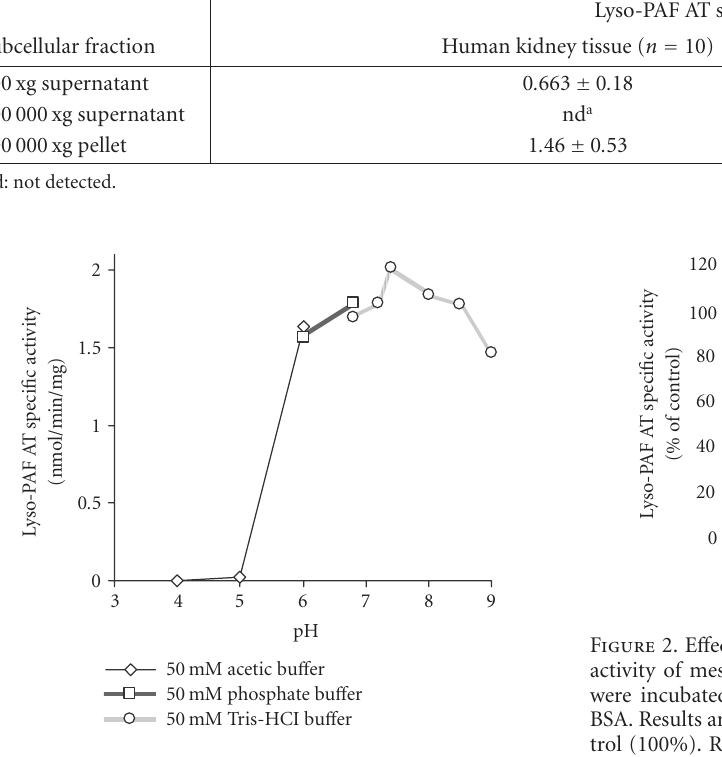
range between 7.2 and 7.4.